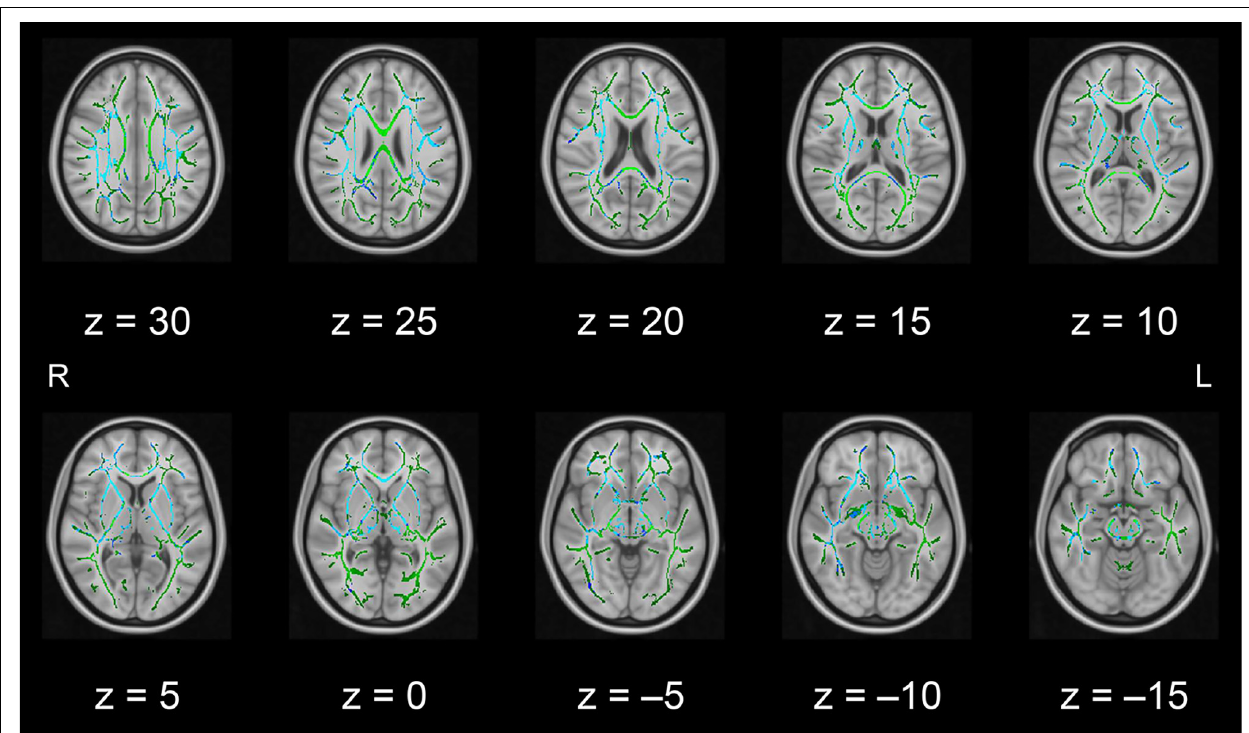
FIGURE 3 | White matter fiber tracts showing significantly lower AD values in the intervention group than in the control group (displayed in blue). The results are overlaid on the mean FA skeleton (shown in green) and the standard MNI152 T1 1-mm 3 brain template. The value of z in the horizontal plane represents the MNI z -coordinate. Abbreviation: AD, axial diffusivity; FA, fractional anisotropy; L, left; MNI, Montreal Neurological Institute; R,